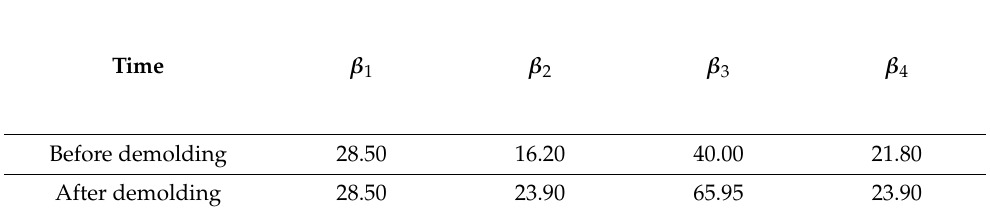
Table 1. Exothermic coefficients of box girder surfaces unit: kJ/ ( m 2 · h · ◦ C )